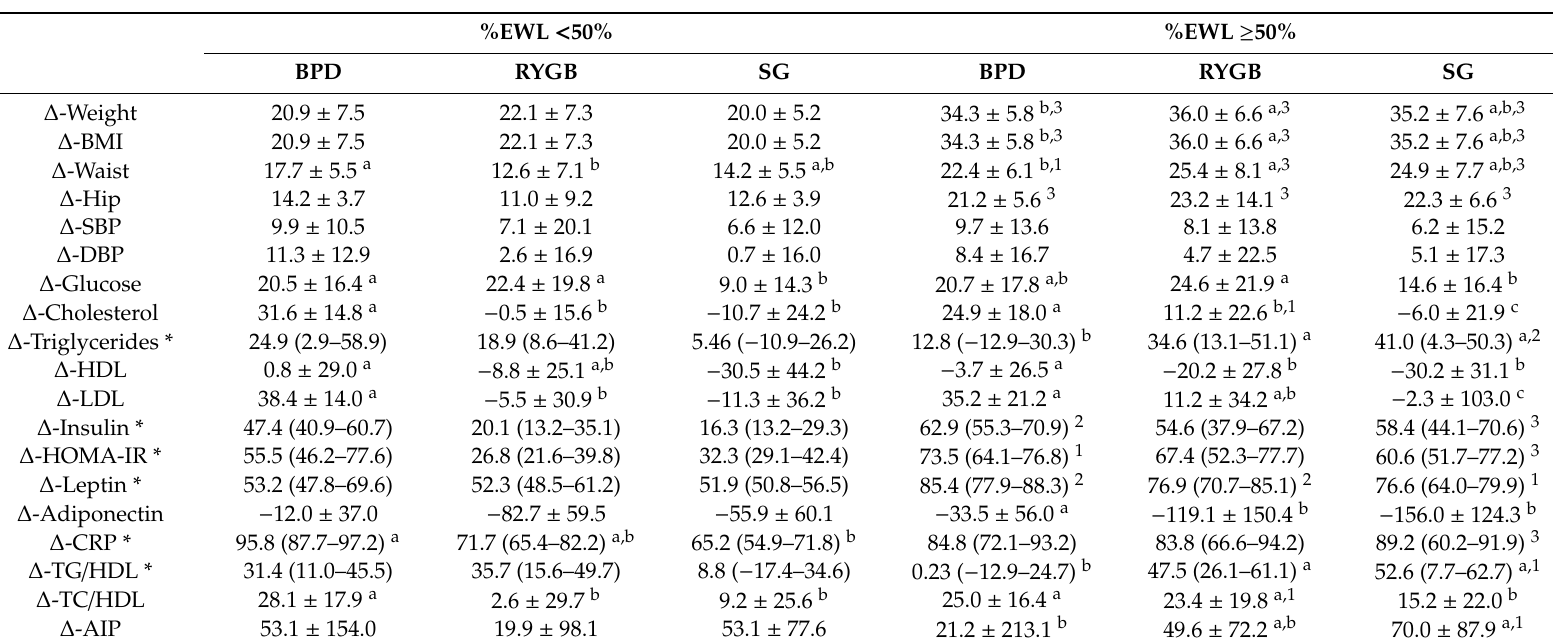
Table 6. Percentage change ( ∆ ) of anthropometric and biochemical variables of patients with morbid obesity classified according to the percentage of excess weight loss (%EWL) and the type of bariatric